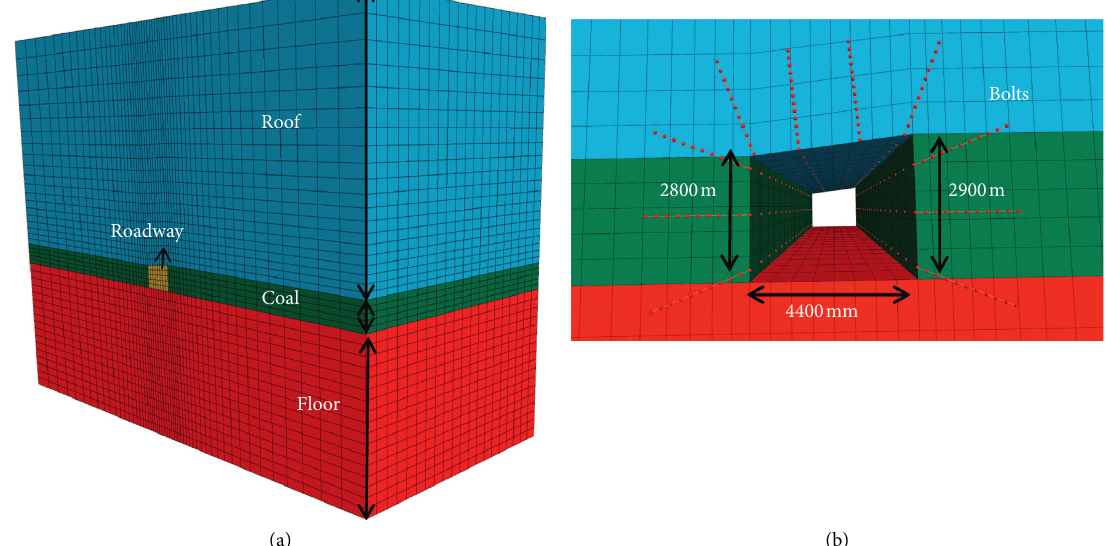
Figure 4: Numerical simulation calculation model: (a) model structure and (b) bolting parameter.